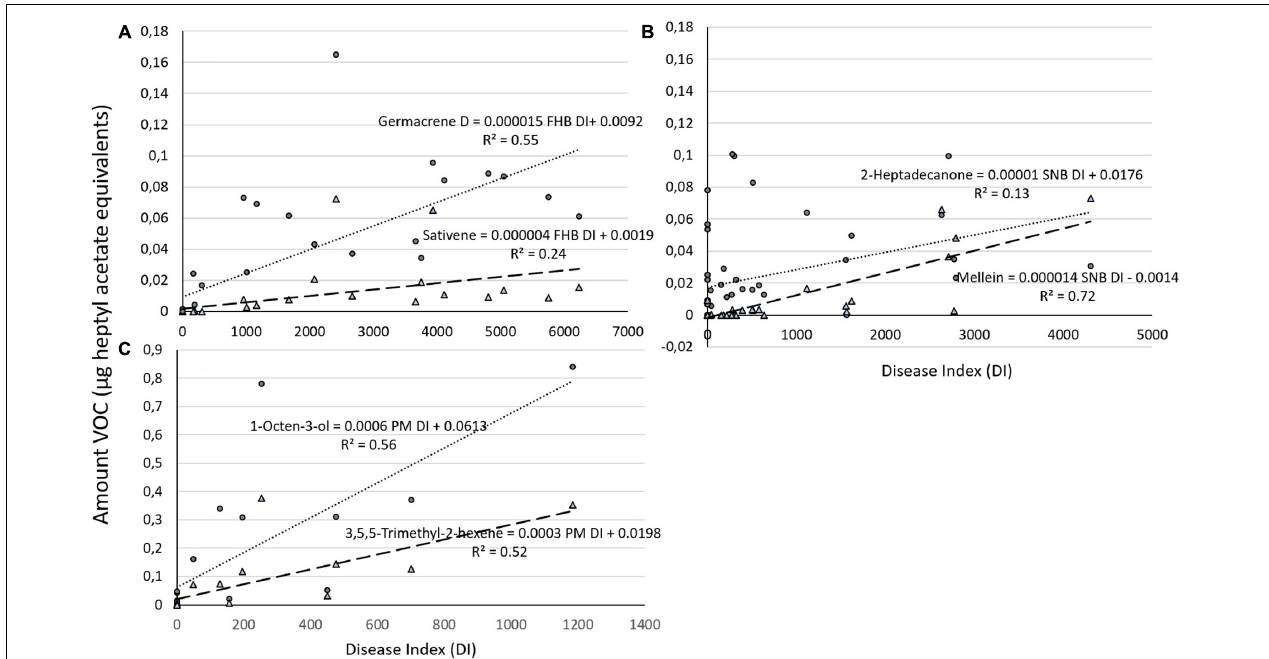
FIGURE 3 | Graphical representation of amount of (A) two different VOCs (germacrene and sativene) regressed against Fusarium head blight (FHB) DI on both varieties (‘Zebra’ and ‘Bjarne’) combined and of (B) two different VOCs (2-heptadecanone and mellein) regressed against Septoria nodorum blotch (SNB) DI on both varieties combined. (C) Graphical representation of the amount of 1-octen-3-ol and 3,5,5-trimethyl-2-hexene regressed against powdery mildew (PM) DI on ‘Bjarne.’ The regression equations and the R 2 value are placed next to the regression